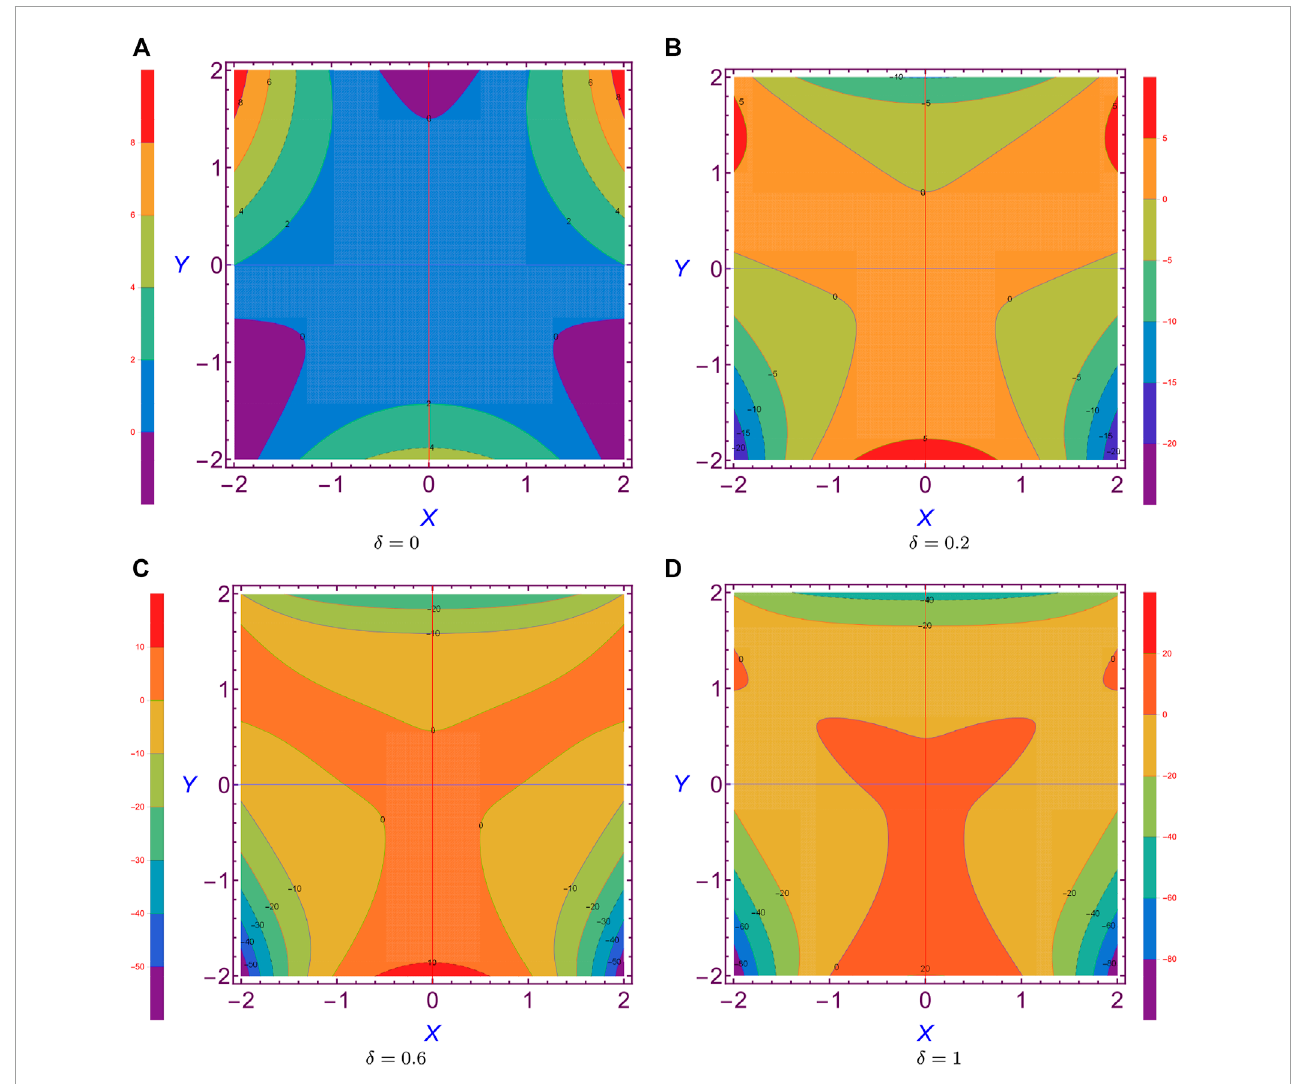
FIGURE 1 Isopleth of the generalized Hénon–Heiles